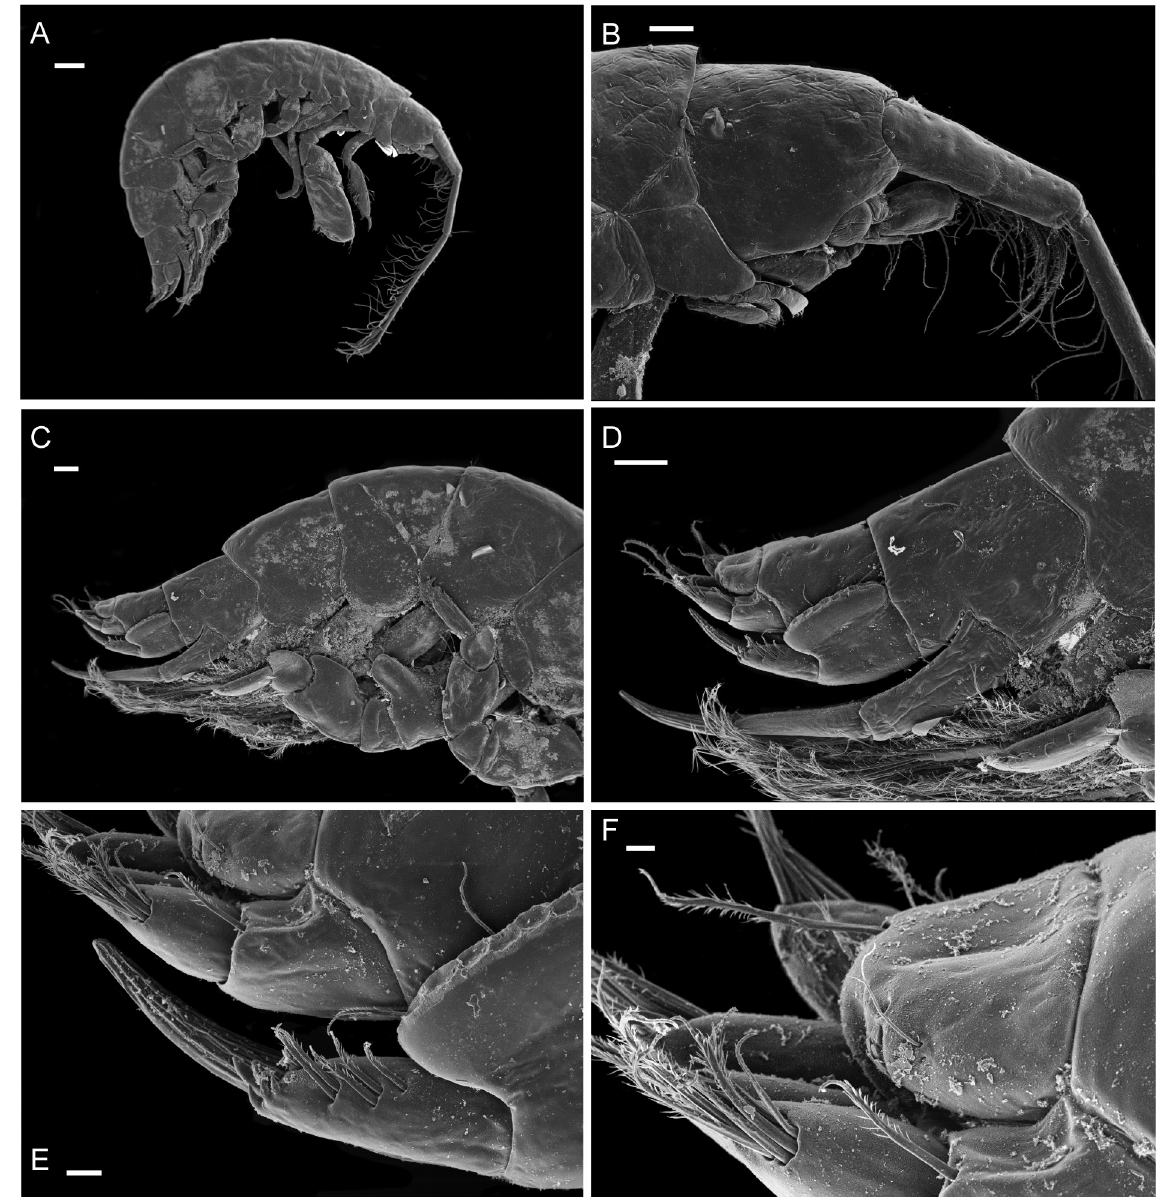
Fig. 7. Bryoconversor tutus gen. et sp. nov., paratype, ♂, NIWA 52919, 0.64 mm long. A . Habitus. B . Head. C . Epimeron. D . Urosome. E . Uropod 2 and uropod 1. F . Telson. Scale bars: A = 300 μm; B-D = 100 μ m; E = 20 μ m; F = 10 μ